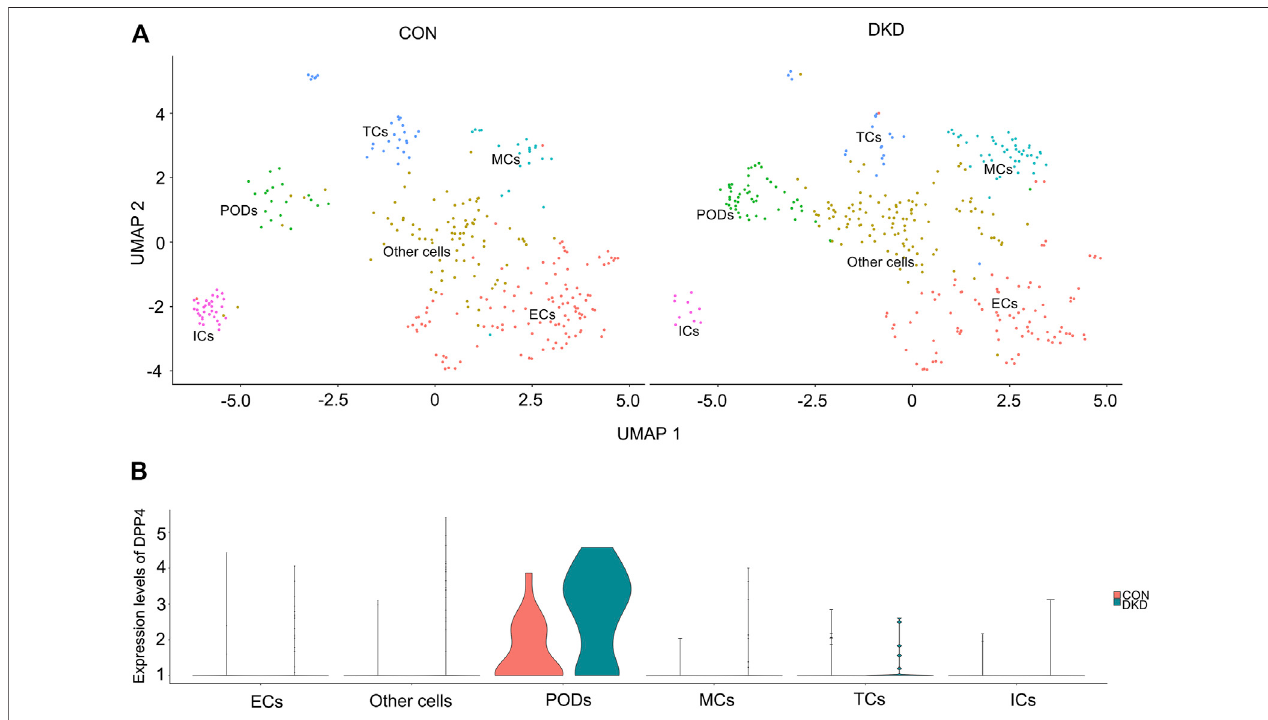
FIGURE 1 | Single-cell sequencing analysis of the mouse control and DKD kidneys. (A) UMAP analysis of kidney cells revealed six types of cell clusters in control (left) and DKD group (right) mice. (B) Single-cell sequencing identi fi ed signi fi cant speci fi c upregulation of Dpp4 in podocytes ( p -value was calculated by Wilcoxon rank sum test, p < 0.001, log (2) FC (cid:1) 1.25). Abbreviation: ECs, endothelial cells; ICs, immune cells; MCs, mesangial cells; PODs, podocytes; TCs, tubular